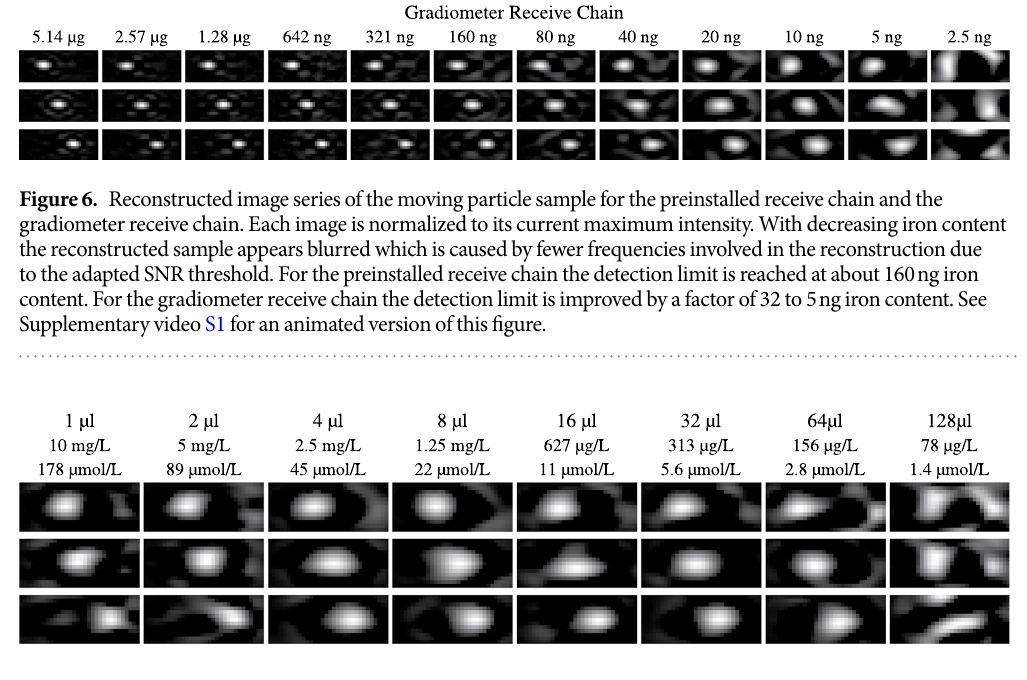
Figure 7. Reconstructed image series of moving particle samples of different concentration. Each sample has the same iron mass of 10 ng but a volume ranging from 1 μ L until 128 μ L. The resulting concentrations range from 78 μ g/L to 10 μ mg/L (1.4 μ mol/L to 178 μ mol/L). The detection limit is reached at about 156 μ g/L (2.8 μ mol/L). See Supplementary video S2 for an animated version of this